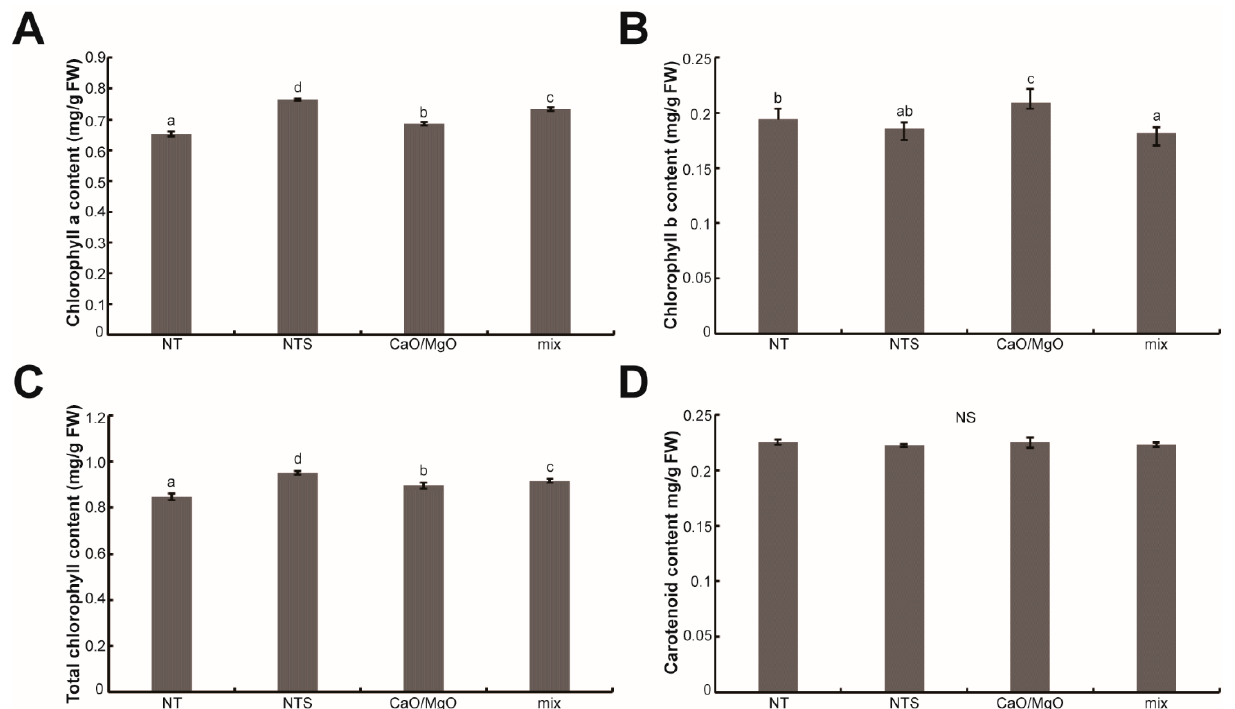
Figure 3. Measurement of chlorophyll and carotenoid in leaf lettuce leaves at one week after the fourth treatment. Chlorophyll a content ( A ), chlorophyll b content ( B ), total chlorophyll content ( C ), and carotenoid content ( D ) in leaf lettuce leaves. NT, nontreatment group; NTS, NTS treatment group; CaO/MgO, CaO/MgO treatment group; mix, mixed (NTS, CaO, and MgO) treatment group. All experiments were repeated three times, and the error bars indicate standard deviation ( n = 9). Different letters above bars indicate statistically significant differences as determined by one-way ANOVA ( p < 0.05).